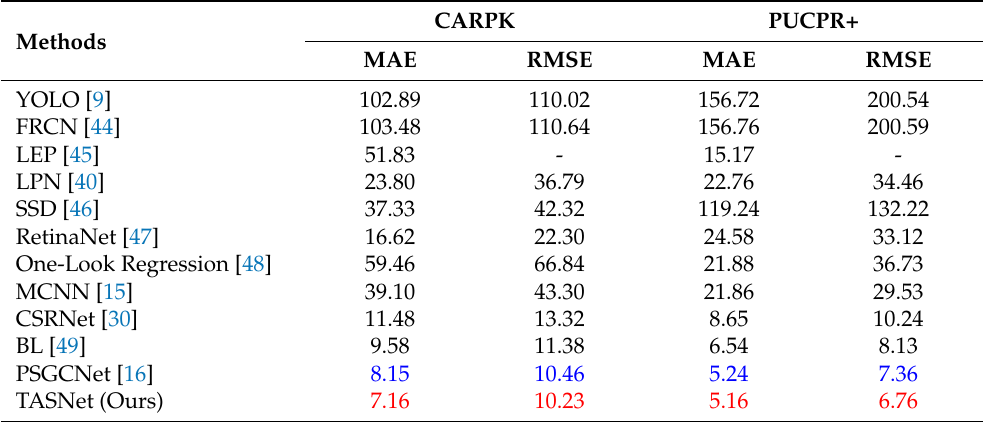
Table 3. Experimental results on the CARPK and PUCPR+ datasets. The best and the second-best results are highlighted in red and blue,